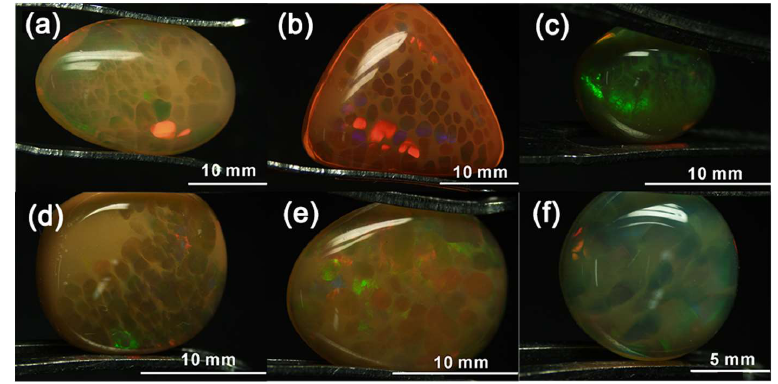
Figure 1. Cabochon samples. ( a ) Opal-01; ( b ) Opal-02; ( c ) Opal-03; ( d ) Opal-04; ( e ) Opal-05; ( f ) Opal-06.